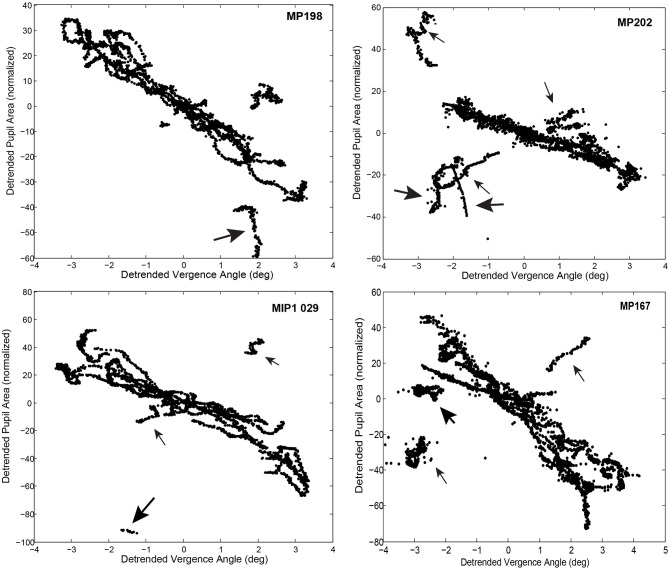
Time-implicit plots of detrended pupil area as function of detrended vergence angle, after subtraction of the pupil area intercept from each linear segment. Note the overlap between the segments representing a coordinated near response pattern. Thin arrows indicate segments with a positively correlated relationship between vergence angle and pupil area. Thick arrows indicate segments with little covariation (uncorrelated eye movement and pupil movement).